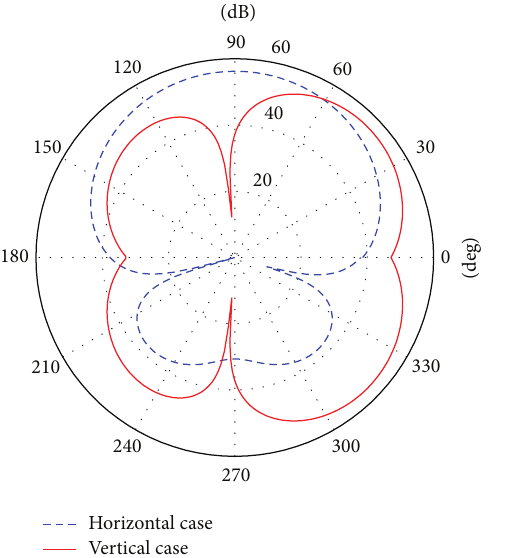
Figure 3: Normalized horizontal and vertical radiation patterns of the BS antenna adopted in the simulation.